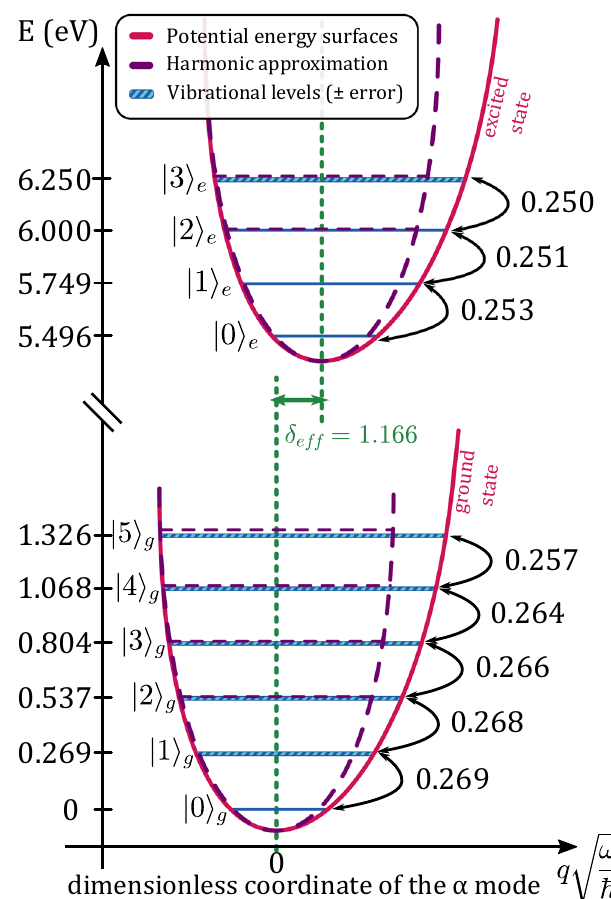
Fig.3|Vibrationalenergydiagramsofgroundandexcitedstatesofthe α mode of C 8 . Vibrational diagram of the ground and excited potential energy surfaces extracted from experimental UVRR and UV-Vis absorption spectra of C 8 and referred to the normal coordinate q of the α mode. The energy (in eV) of each vibrational level ∣ k i j of the j th state is reported in the left axis, while the energy of the ∣ 0 i g levelis fi xedto0eV.Thethicknessofthevibroniclinesrepresentstheerror of the fi t model used to deconvolve the UVRR and UV-Vis absorption spectra. The spacingbetweenneighboringvibrationallevels ð Ω k , j Þ isdisplayedontherightineV and indicated by black arrows. The purple dashed curves and lines represent the harmonic approximation of the potential energy surfaces and vibrational levels, respectively. The effective displacement parameter δ eff is reported in